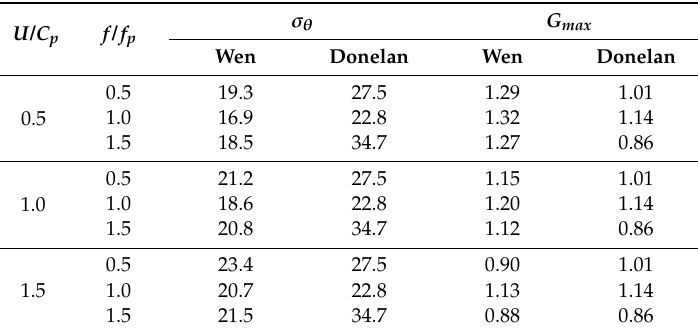
Table 1. Directional distribution function and statistical results of the maximum at different wind speed and different frequencies for different directional functions.